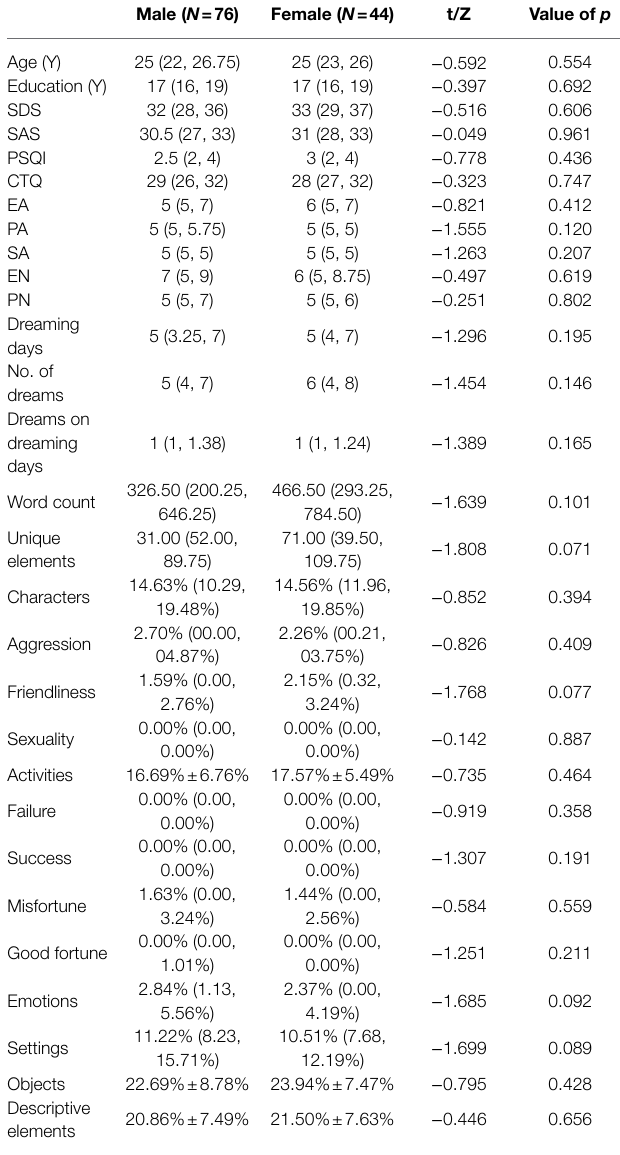
SDS, Zung Self-Rating Depression Scale; SAS, Zung Self-Rating Anxiety Scale; PSQI, Pittsburgh Sleep Quality Index; CTQ, Childhood Trauma Questionnaire; EA, emotional abuse; PA, physical abuse; SA, sexual abuse; PN, physical neglect; and EN, emotional neglect. The data that conformed to a normal distribution are presented as the mean ± standard deviation (SD), and the data that did not conform to a normal distribution are presented as the median (interquartile range). Dream content characteristics were calculated as